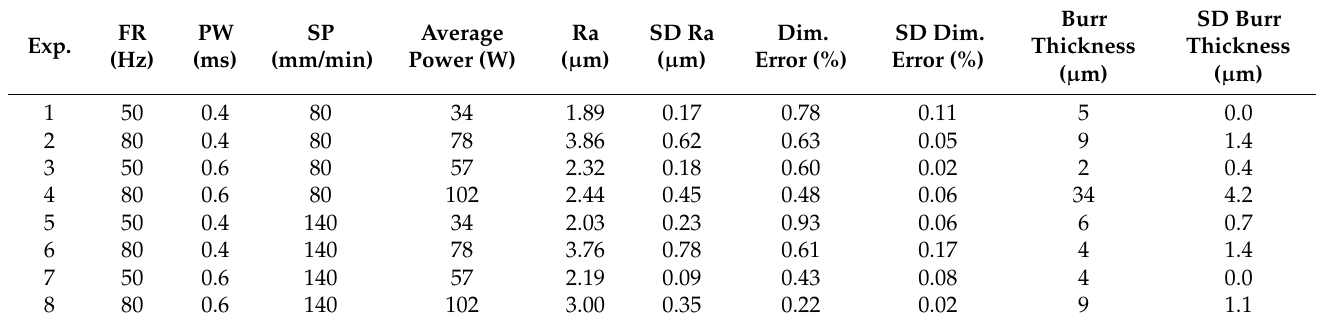
Table 3. Roughness Ra results (average value of the two replicates). SD means standard deviation.